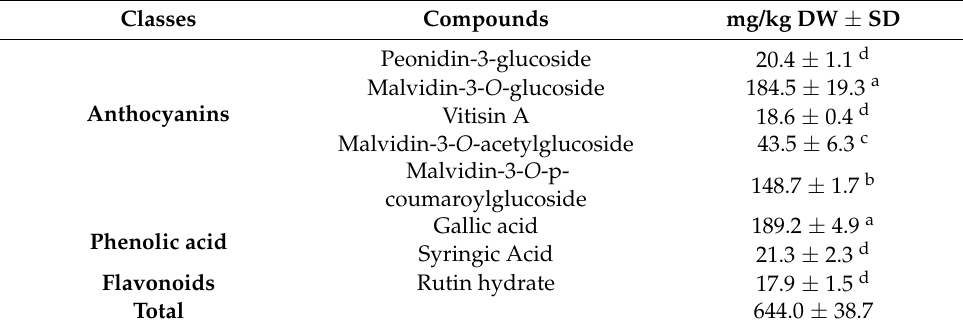
Table 2. Quantified sample content (mg/kg DW ± SD) of the main classes of phenolic compounds by the UHPLC-DAD